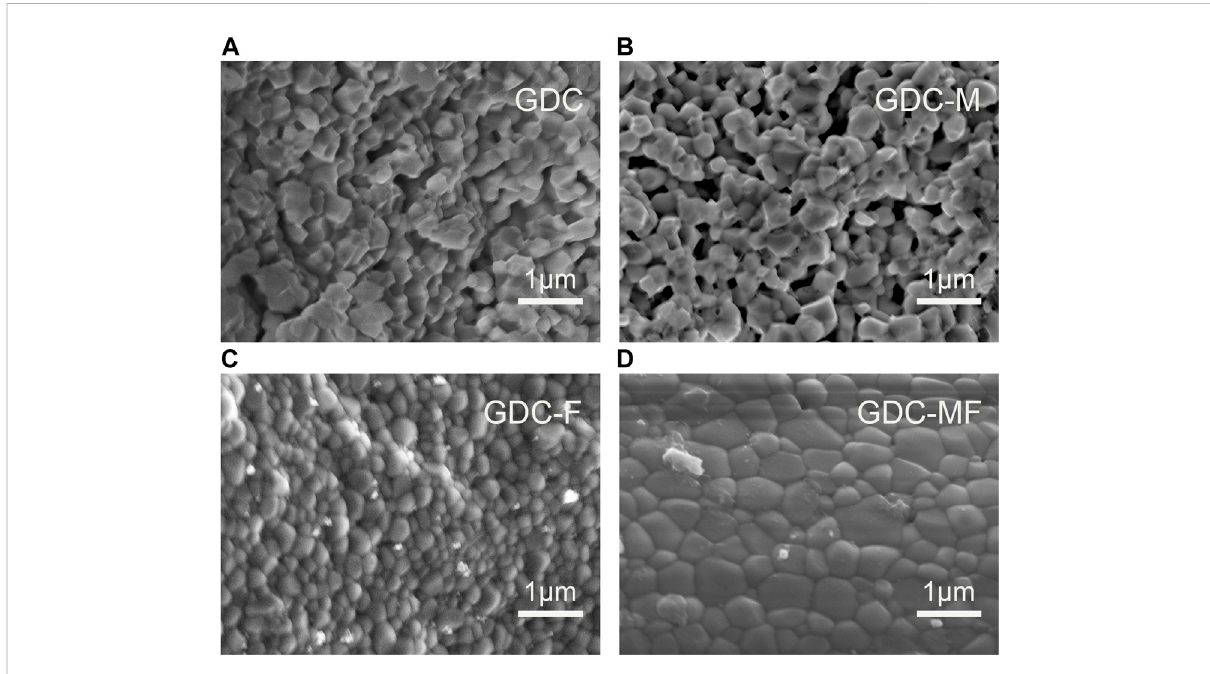
FIGURE 4 Cross-sectional FE-SEM image of (A) GDC, (B) GDC-M, (C) GDC-F and (D) GDC-MF electrolytes sintered at 1200 ° C for 10